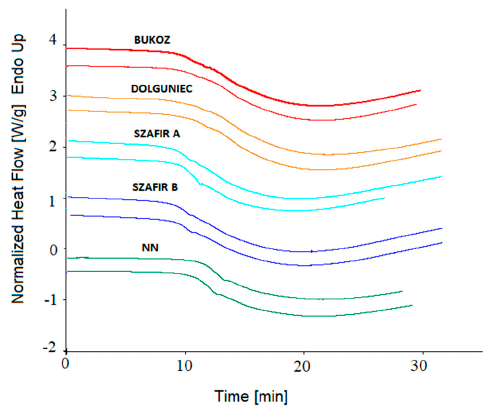
Figure 5. DSC isothermal oxidation curves obtained at 140 ◦ C for cold-pressed flaxseed oils.